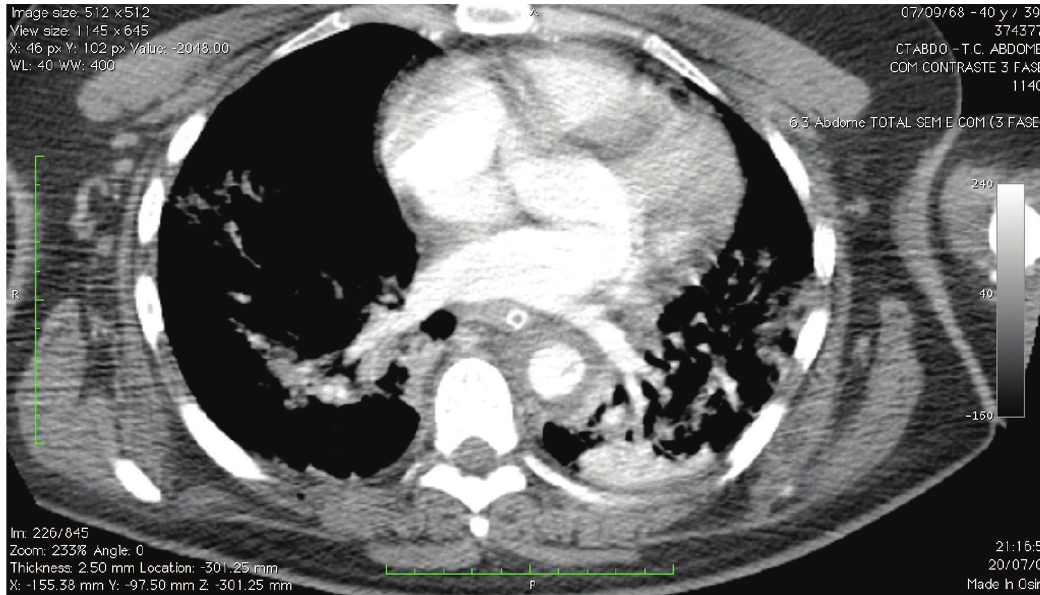
Figure 5 - Minimal aortic injury. Initial angiotomography – intimal